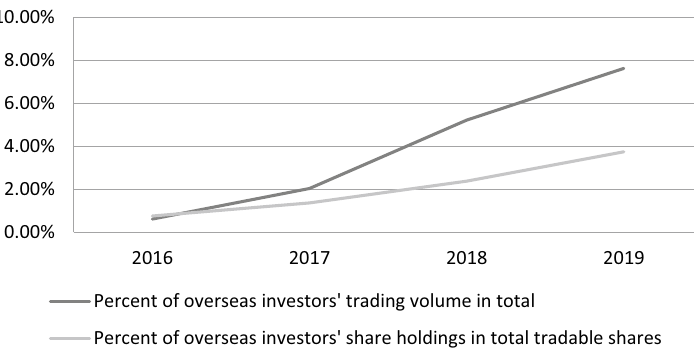
Fig. 2 Percentages of overseas investors’ trading volume and share